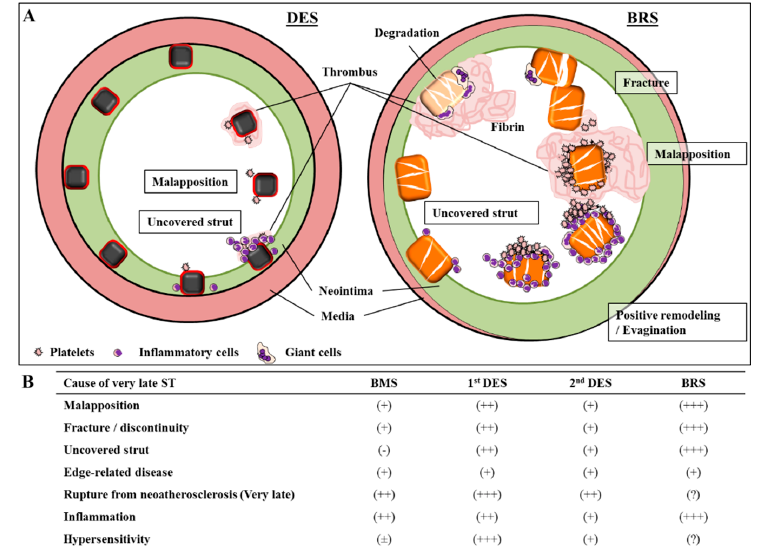
Figure 3. Various mechanisms of very late stent (ST) and scaffold thrombosis (ScT). ( A ) Diagram illustrating the various mechanisms of very late stent (ST) (left) and scaffold thrombosis (ScT) (right). ( B ) Impact of each factor and its relationship to ST and ScT in different devices—BMS = bare metal stents, DES = drug-eluting stents, BRS = bioresorbable vascular scaffold. Permission obtained from Mori, H; et al. Coron. Artery Dis. 2017 [54].